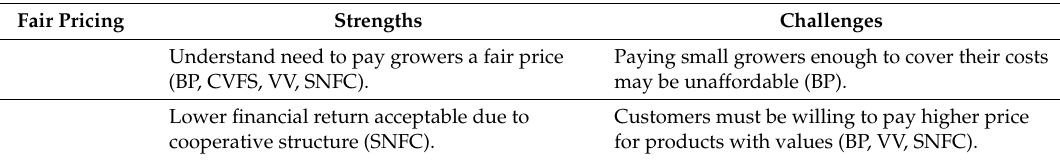
Table 1. Cont. Fair Pricing Strengths Challenges Understand need to pay growers a fair price Paying small growers enough to cover their costs (BP, CVFS, VV, SNFC). may be unaffordable (BP). Lower financial return acceptable due to cooperative structure